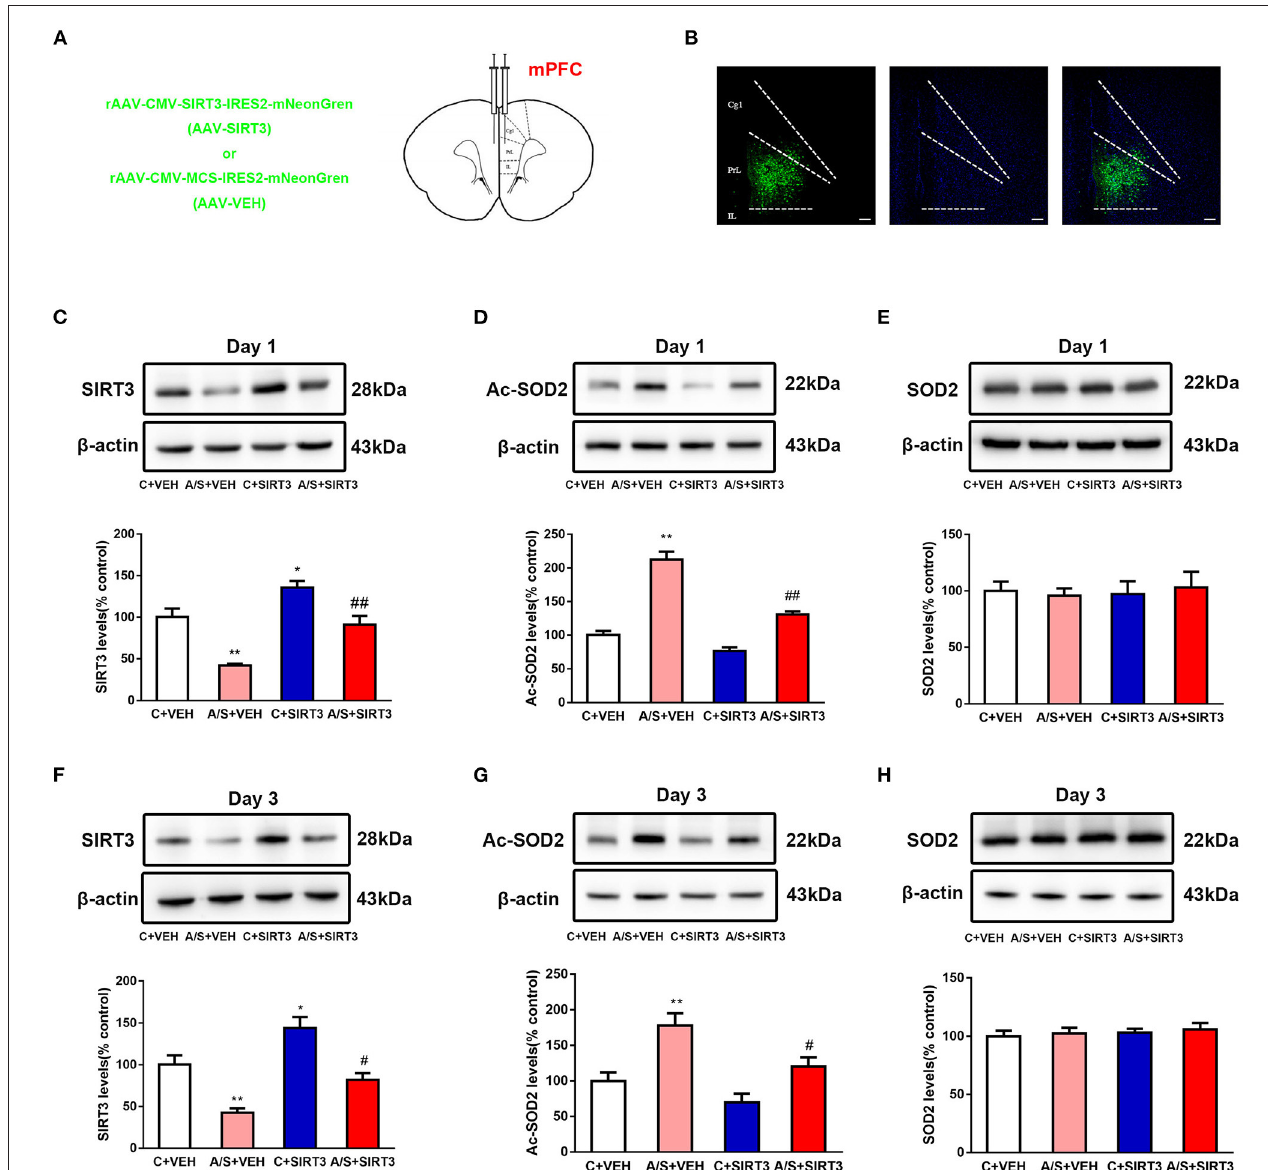
FIGURE 2 | Effect of SIRT3 overexpression on SOD2/Ac-SOD2 levels. (A) Location of AAV-SIRT3 or AAV-VEH microinjection in the mPFC of mice. (B) AAV-SIRT3 vector expression in mice mPFC region is shown on fluorescence images. (C-H) SIRT3, Ac-SOD2, and SOD2 expression among the four groups on days 1 and 3 is shown by western blotting and quantification ( n = 6 per group, * p < 0.05; ** p < 0.01; # p < 0.05; ## p < 0.01). Data are presented as the means ±